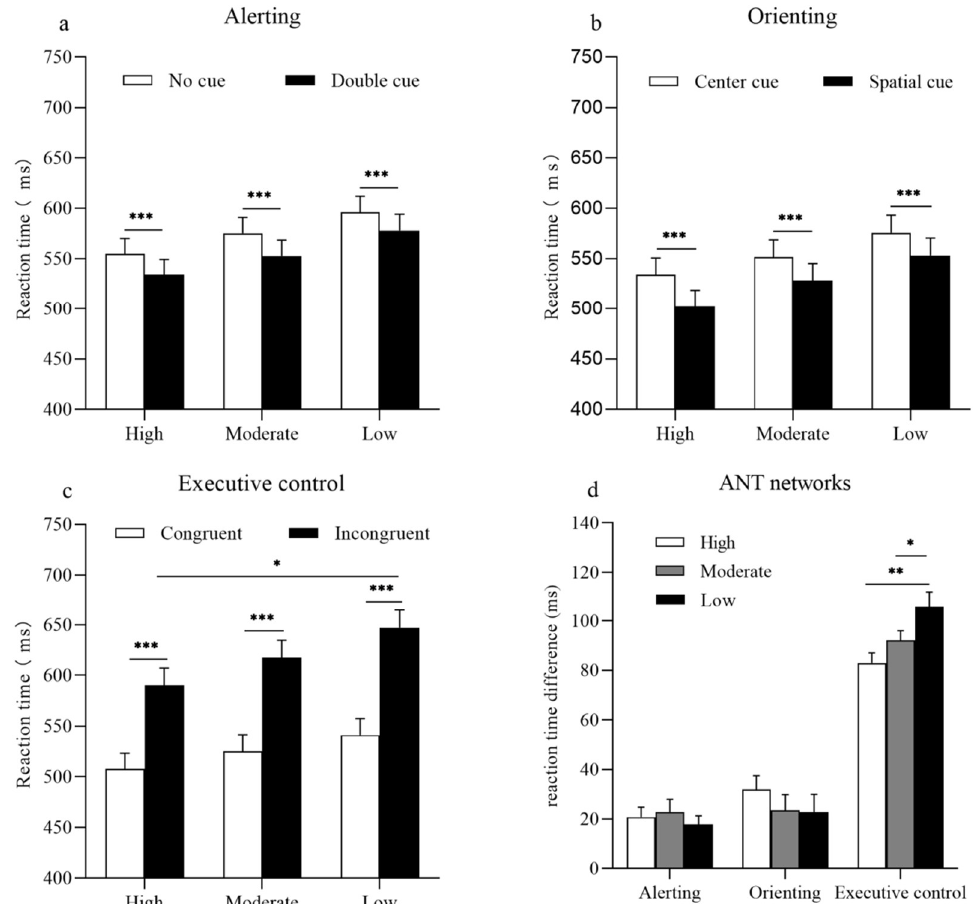
Figure 2. Reaction times for three levels of physical activity in each network. ( a ) For the alerting network, the bars represent mean reaction times as a function of an alerting effect and physical activity group. White bars represent reaction times for the no cue condition, and black bars represent reaction times for the double cue condition. ( b ) For the orienting network, the bars represent mean reaction times as a function of an orienting effect and physical activity group. White bars represent reaction times of the central cue condition, and black bars represent reaction times of the spatial cue condition. ( c ) For the executive control network, the bars represent mean reaction times as a function of a congruency effect and physical activity group. White bars represent reaction times for the congruent condition, and black bars represent reaction times for the incongruent condition. ( d ) Bars represent the reaction time differences between a specific cue or a flanking condition that reflect the efficiency of the Attention Network Test (ANT) networks for the high, moderate, and low PA groups. Error bars represent standard error of mean (SEM). * p < 0.05; ** p < 0.01; *** p < 0.001.